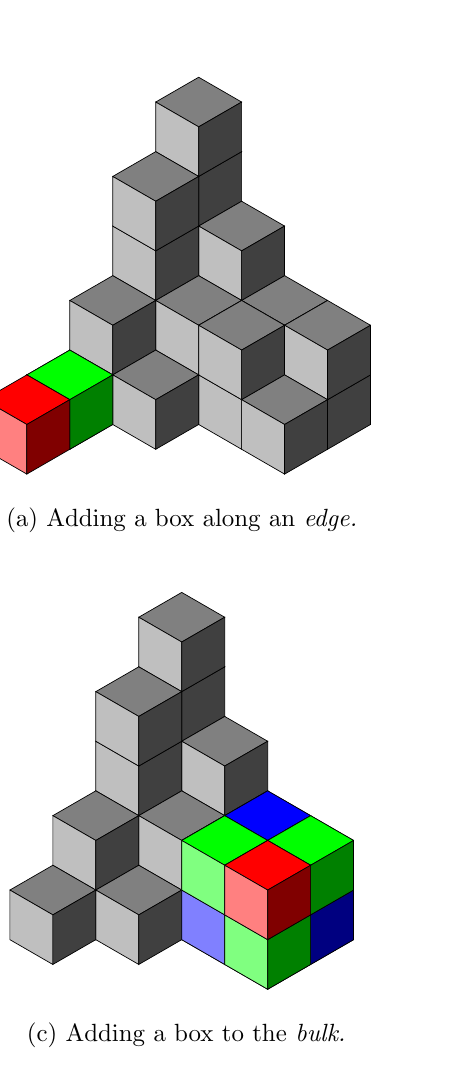
Figure 2. Several ways to add the ( k + 1) th box (the red one) given an arrangement of k boxes. At the same time we add an integral over u k +1 . We coloured in green those boxes whose position di(cid:11)ers, from that of the red one, by (cid:15) a ; in blue those boxes whose position di(cid:11)ers by (cid:15) ab . From table 2 we see that a green box increases the singularity order of the integrand by 1, while a blue box decreases it by 1. In case (a) we increase the order by 1, therefore the pole contributes. In case order by 3 + 1 (cid:0) 3 = 1, therefore the pole contributes. In case (d) there is no change in the